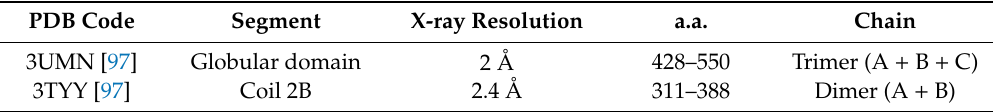
Table 2. Wild type human lamin B1 fragments obtained by